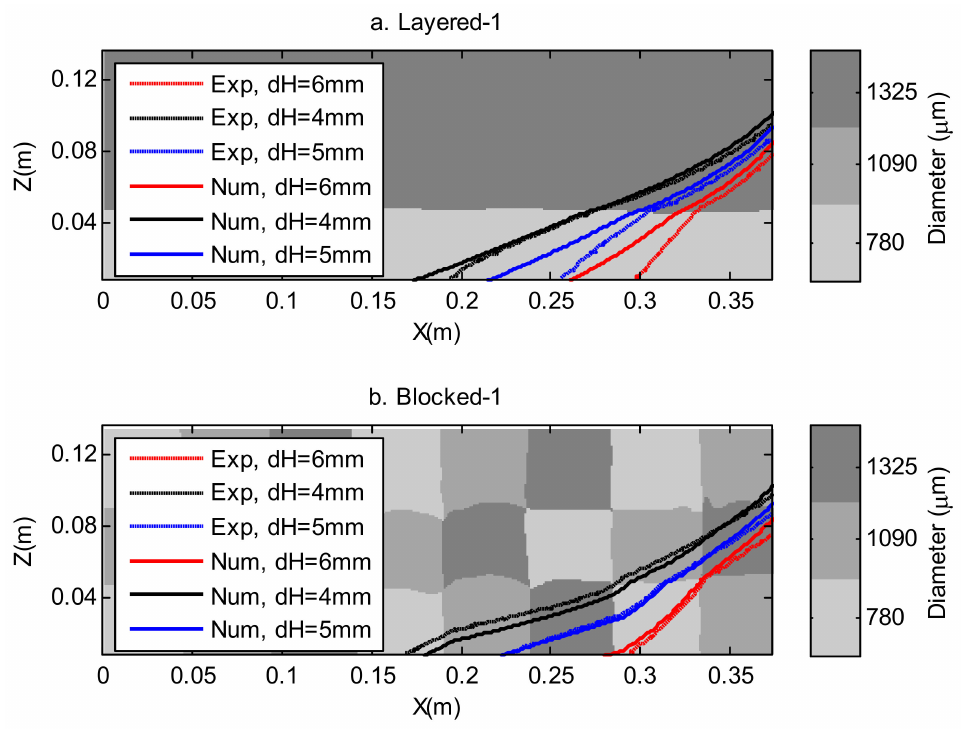
Figure 3. Experimental and numerical steady-state 50% salt concentration isolines for the ( a ) Layered- 1 case and ( b ) Blocked-1 case at head differences, dH = 6 mm, 4 mm, and 5